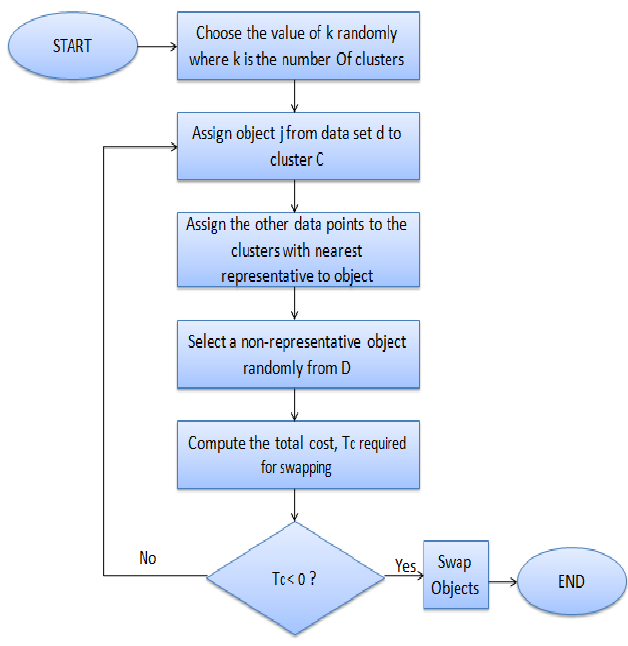
Fig. 6. K -medoids